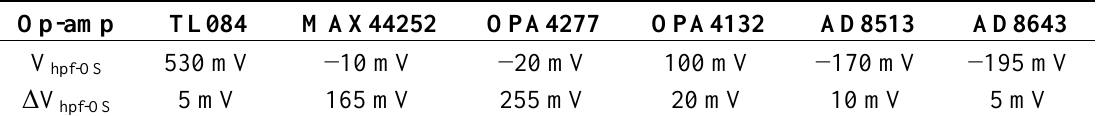
Table 5. Output DC offset measured at the v with the circuit in Figure